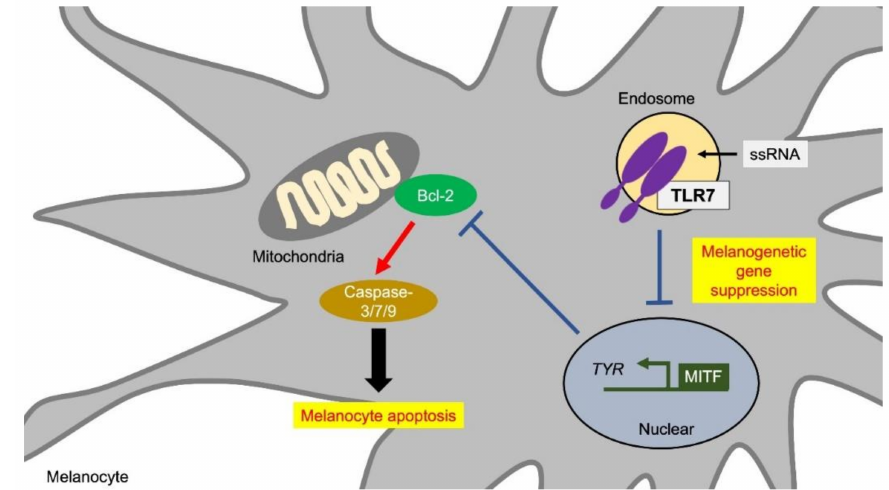
Figure 5. TLR7 inhibits melanogenesis and induces melanocyte apoptosis. TLR7 stimulation